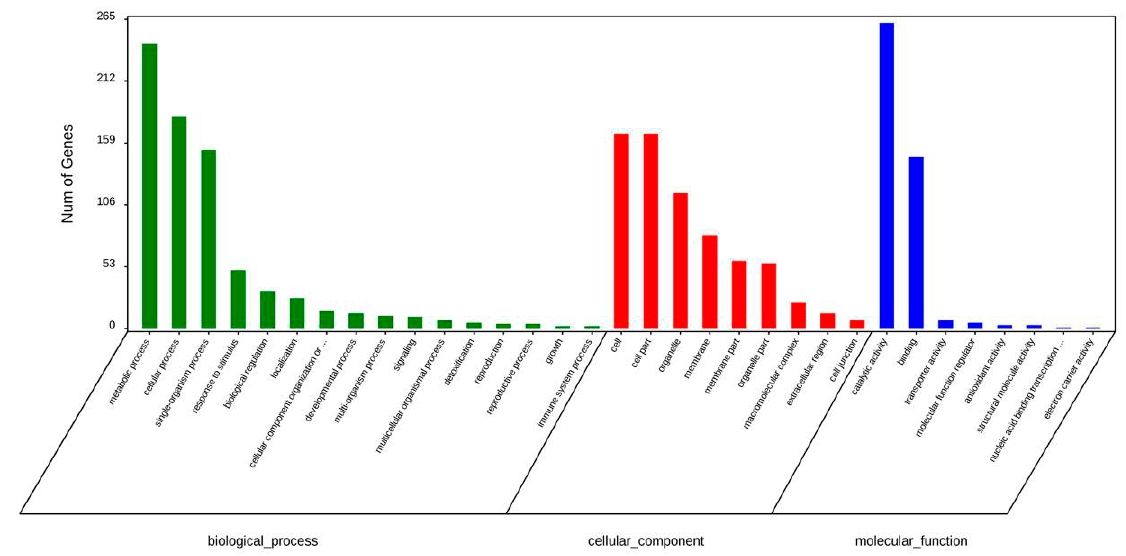
Figure 2. Gene ontology (GO) analysis of differentially accumulated proteins in Euphorbia kansui latex.